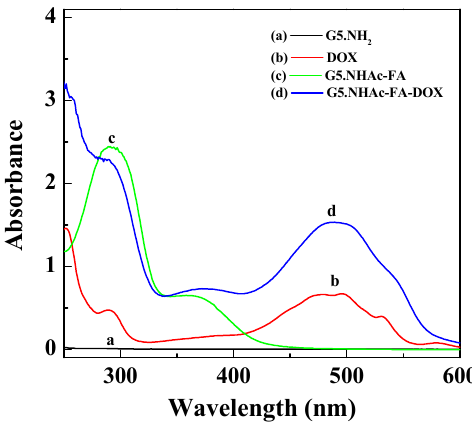
Figure 1. UV-vis spectra of G5.NH 2 dendrimers, DOX · HCl, G5.NHAc-FA dendrimers, and G5.NHAc- FA-DOX conjugates in aqueous solution.